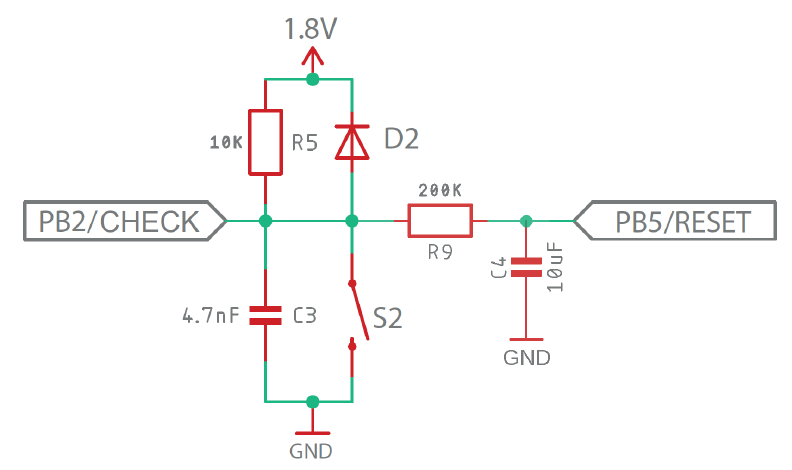
Figure 11. Switch button schematic